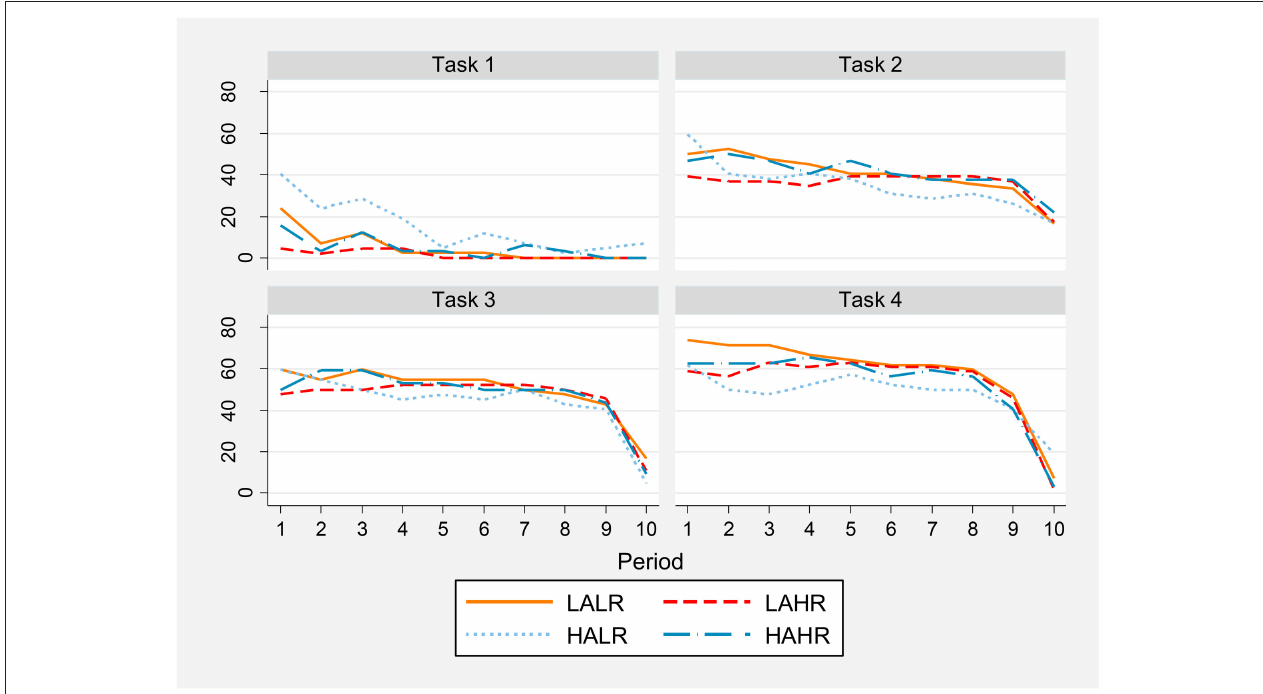
FIGURE 6 | Percentage of individual cooperation by task, period and treatment.